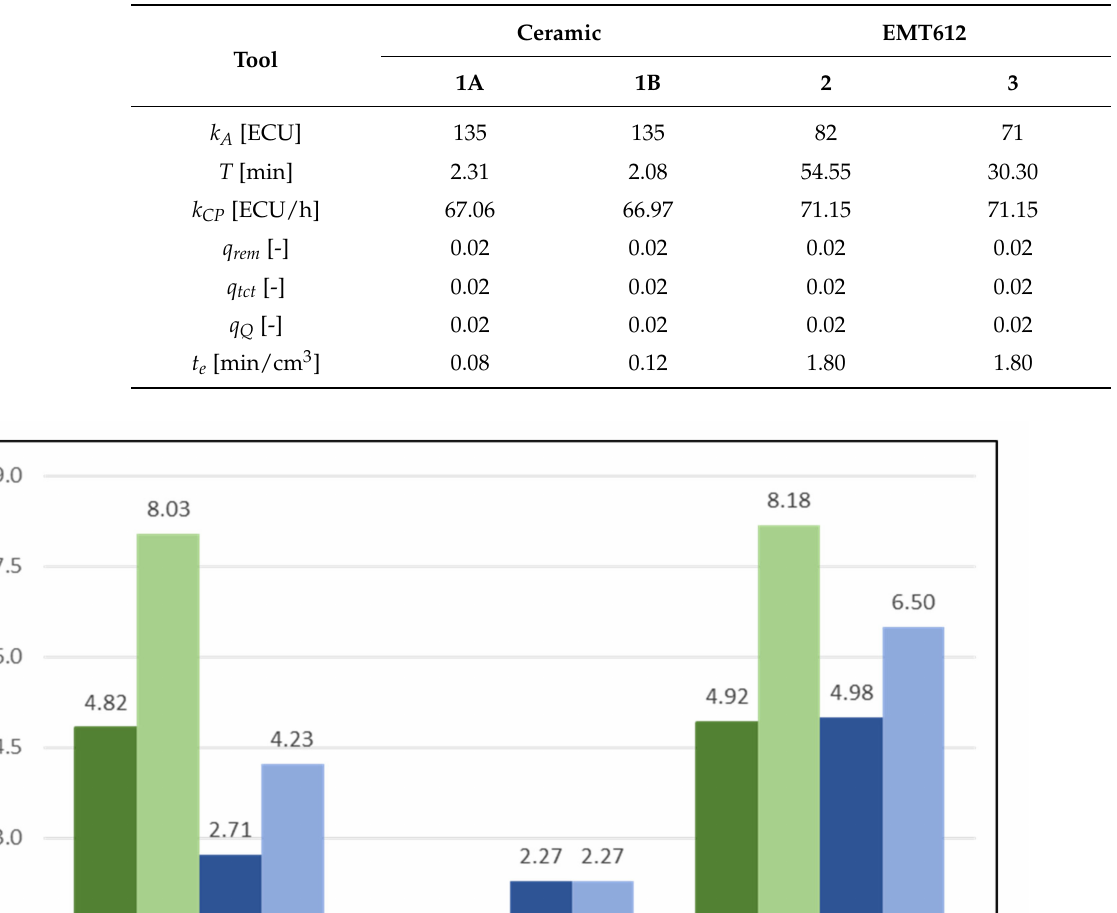
Table 3. Parameters to calculate the CPR.